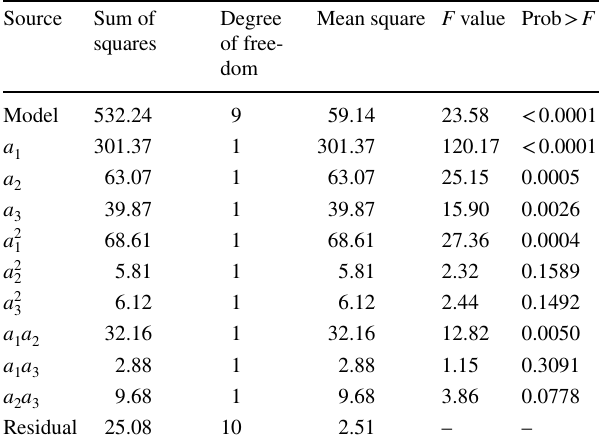
Table 4 The ANOVA for response surface quadratic model of CSSS-